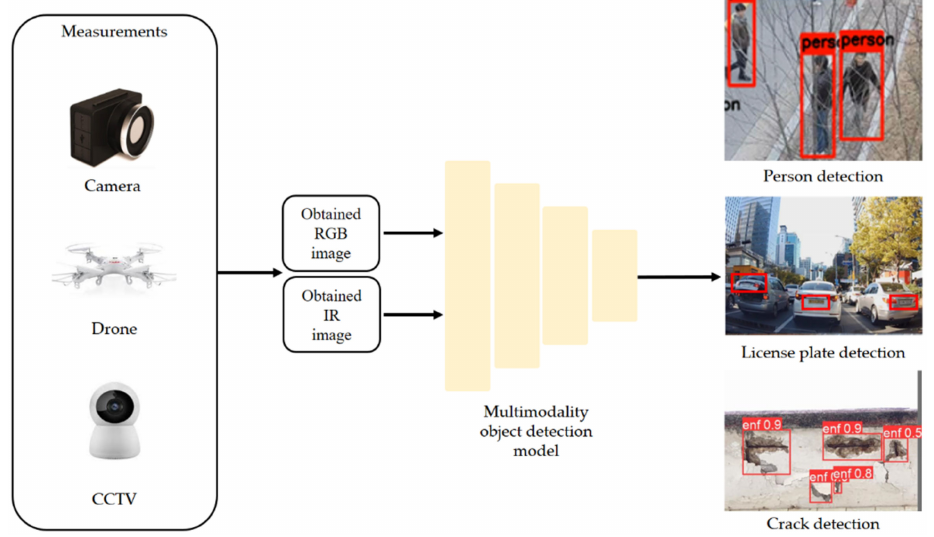
Figure 1. Example applications of the multimodality object detection model.